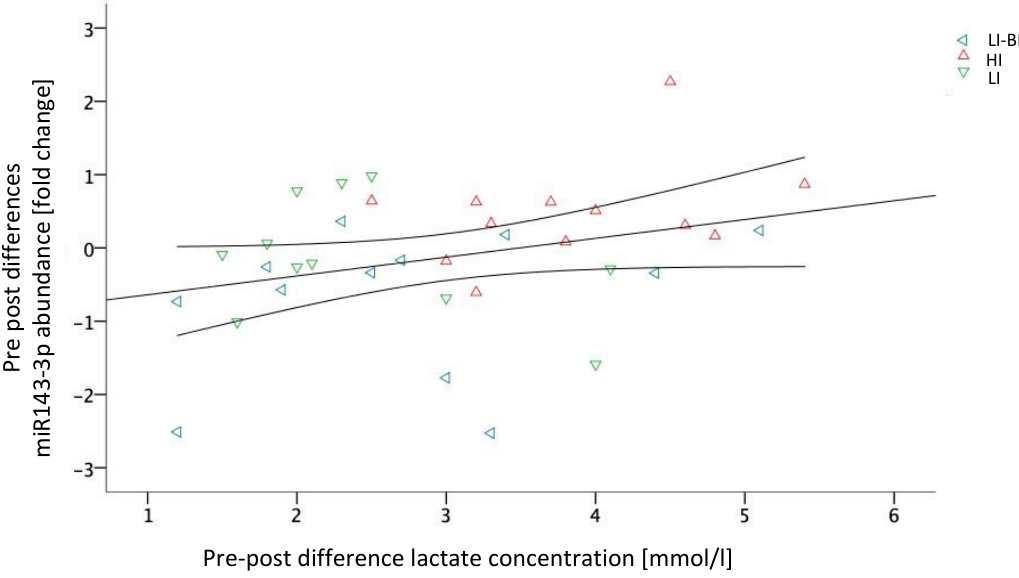
Figure 7. Scatterplot diagram of miR-143-3p and lactate concentration with a correlation line (including confidence intervals); LI-BFR, low-intensity training with blood flow restriction; HI, high-intensity training, LI, low-intensity training.